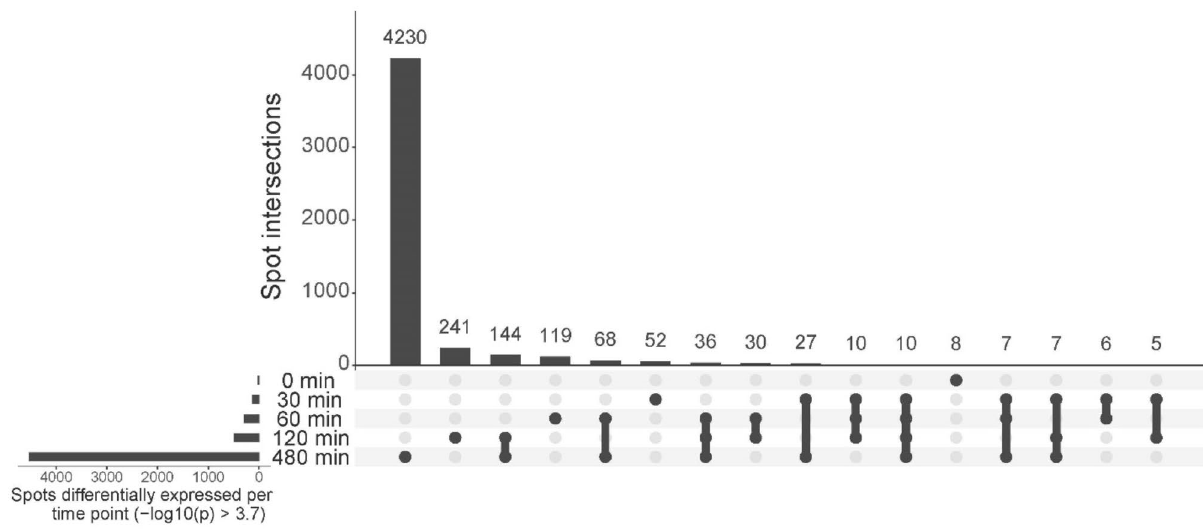
Figure 3. UpSet plot of the linear model. In the lower left corner, the total number of differentially expressed spots between 0 mM versus 400 mM ethanol exposed animals can be observed per time point (− log10(p) > 3.7). The dots, lines, and bars represent the overlap of differentially expressed spots between the various time-points. For example: at 480 min, 4230 spots are only differentially regulated between the two treatments; hence, 144 spots are differentially regulated between 0 and 400 mM ethanol at both 120 min and 480 min of